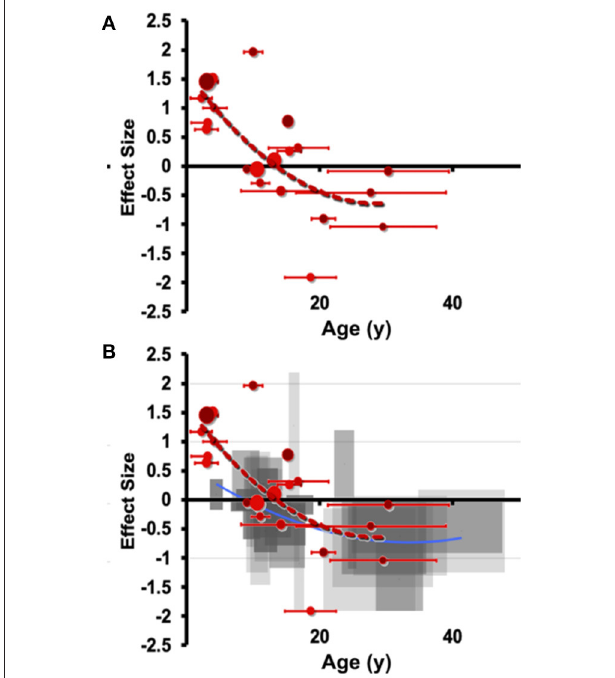
FIGURE 4 | Meta-analytic evidence for a transdiagnostic allostatic curve. Manual hand-tracing studies of (A) amygdala volume differences in individuals with autism (ASD) compared to those with autism. Effect size (hedges g) is shown on the vertical axis, with age shown on the horizontal axis (error bars indicate SD of age). Effect sizes are small volume corrected or corrected with total brain volume or intracranial volume. Of note, these samples meet the stricter DSM-IV represented by the smallest reported subgrouping by age. (B) Overlaying with the less steep curve of right amygdala from ASD shows a highly similar pattern of shrinkage that is at least as early as the onset seen in